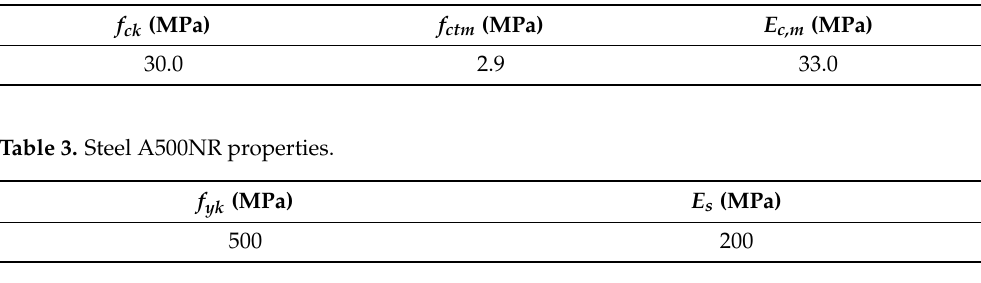
Figure 13. Stress distribution in a cracked RC cross-section with 10 layers in SAP 2000.